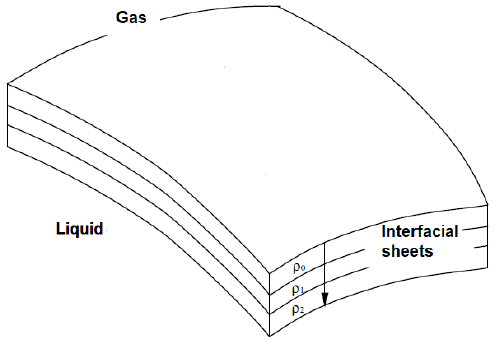
Figure 2. The Newtonian interface according to the Boussinesq model: pressure equalization by the density gradient.